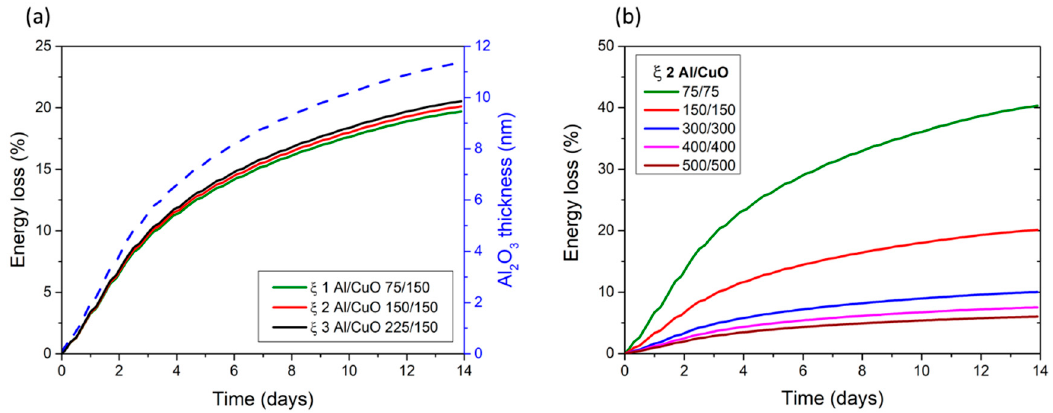
Figure 6. Time evolution of the energy loss EL% upon 200 °C aging conditions for, ( a ) three different stoichiometries ( ξ 1–3), ( b ) ξ 2 stack with five bilayer thicknesses w = 150, 300, 600, 800, and 1000 nm.